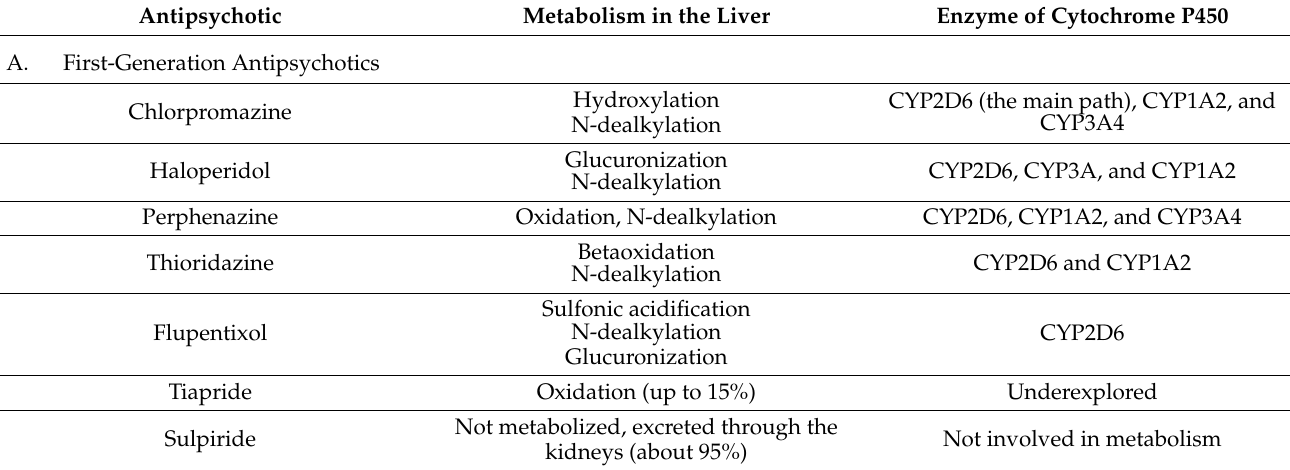
Table A5. Antipsychotics with hepatic and predominantly hepatic